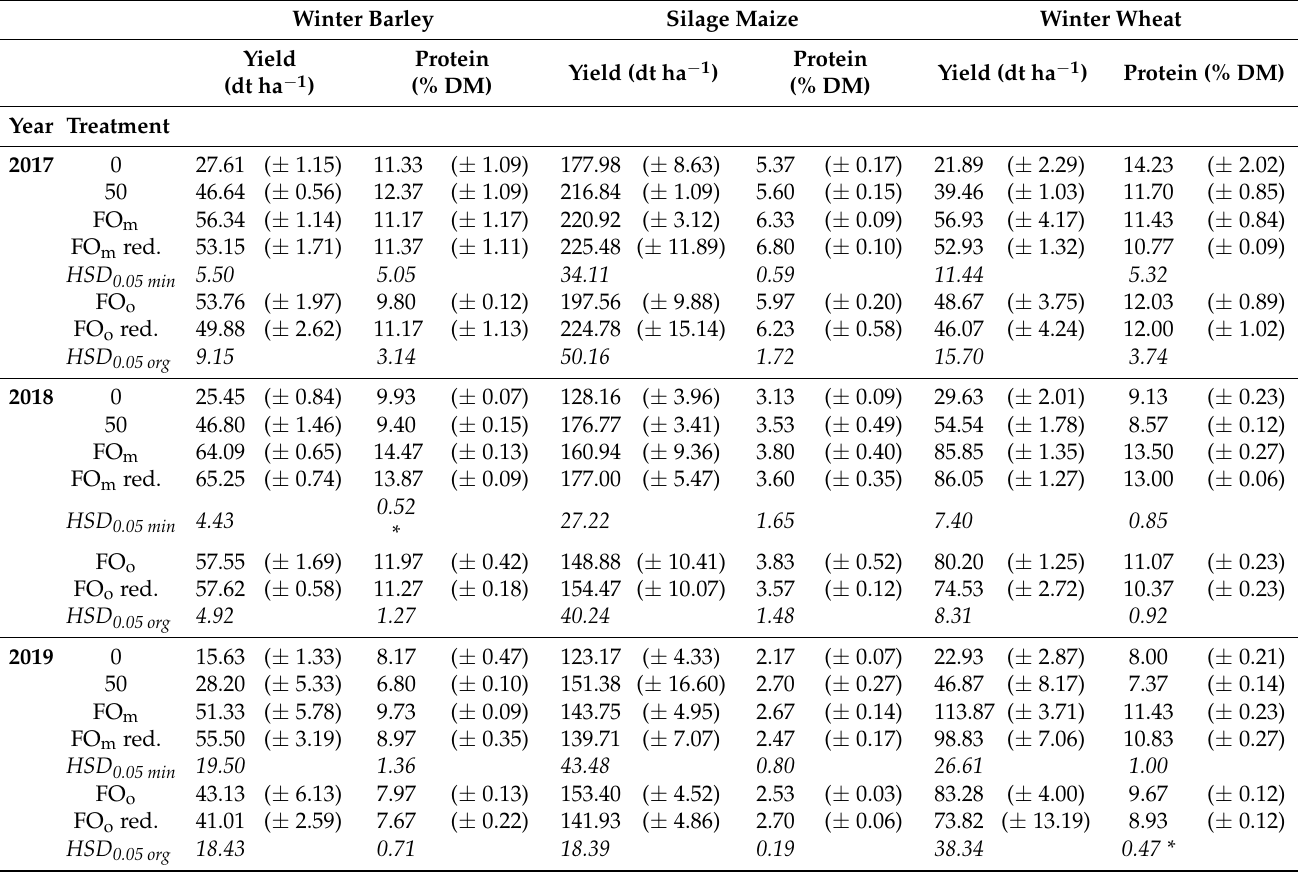
Table 3. Yield (grain yield at 86% dry matter (DM) for cereals and total DM yield for silage maize) and protein concentra- tions (± standard error) with results of Tukey-test within mineral (m) and organic + mineral (o) fertiliser treatments (HSD 0.05 ); FO: fertiliser ordinance, red: reduced; * significant.